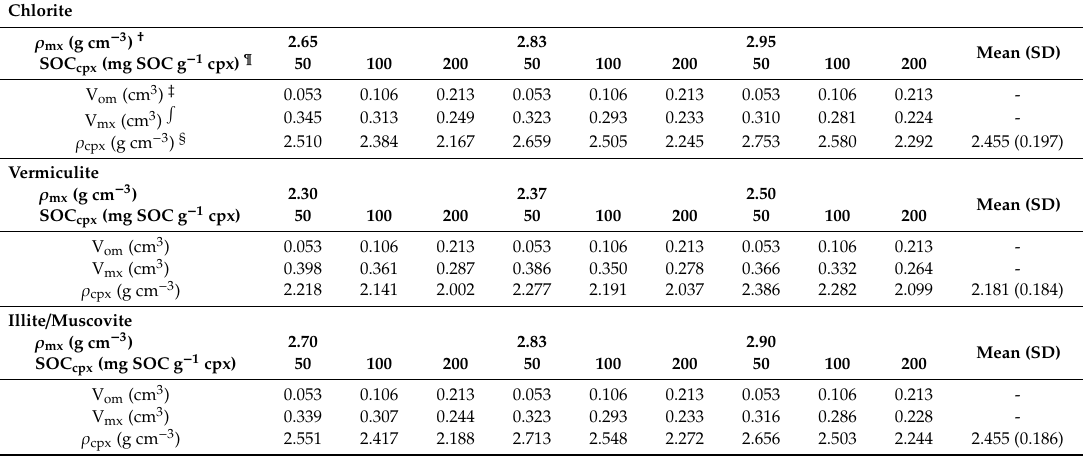
Table A2. Estimation of organo-mineral complex density for minerals having a high specific surface area.